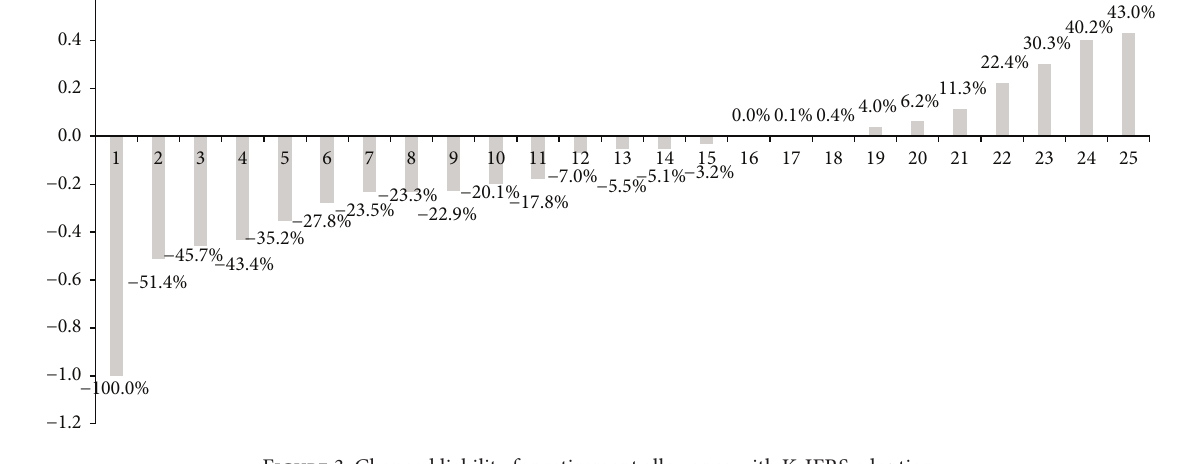
Figure 3: Changed liability for retirement allowance with K-IFRS adoption.